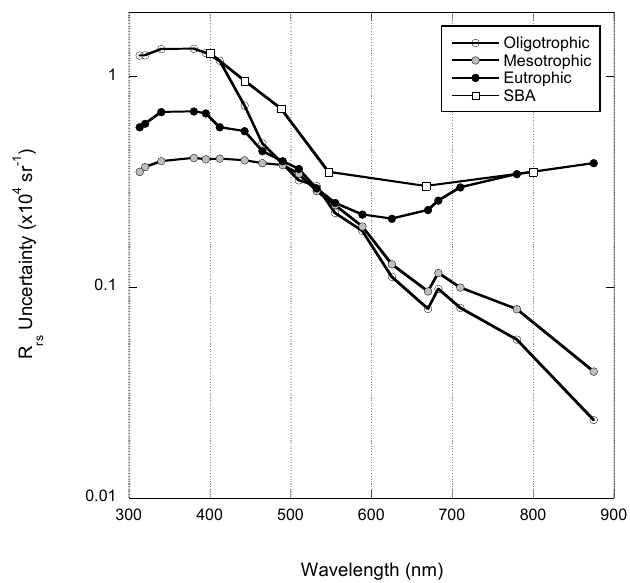
Figure 3. Remote-sensing reflectance (R rs ) uncertainty (sr − 1 ) calculated from field measurements using a Compact-Optical Profiling System (C-OPS) profiling radiometer (circles) for oligotrophic (open), mesotrophic (grey), and eutrophic (black) sites corresponding to Crater Lake, OR; Grizzly Bay, CA; and Lake Tahoe, CA. For comparison, values from [23] are shown (squares) for the skylight-blocked approach (SBA) approach from oligotrophic marine waters.